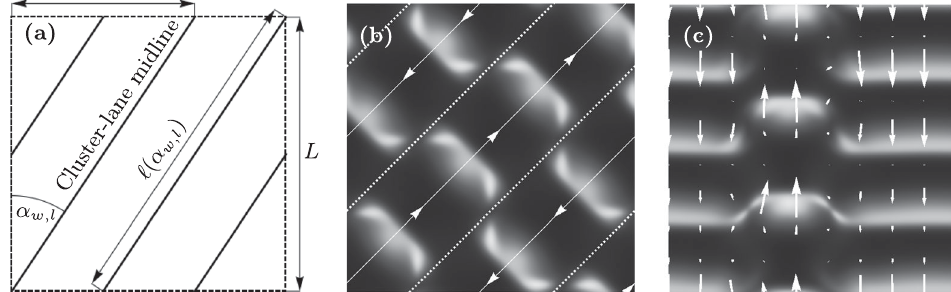
π = 4 , observed in a system of ; 1 ¼